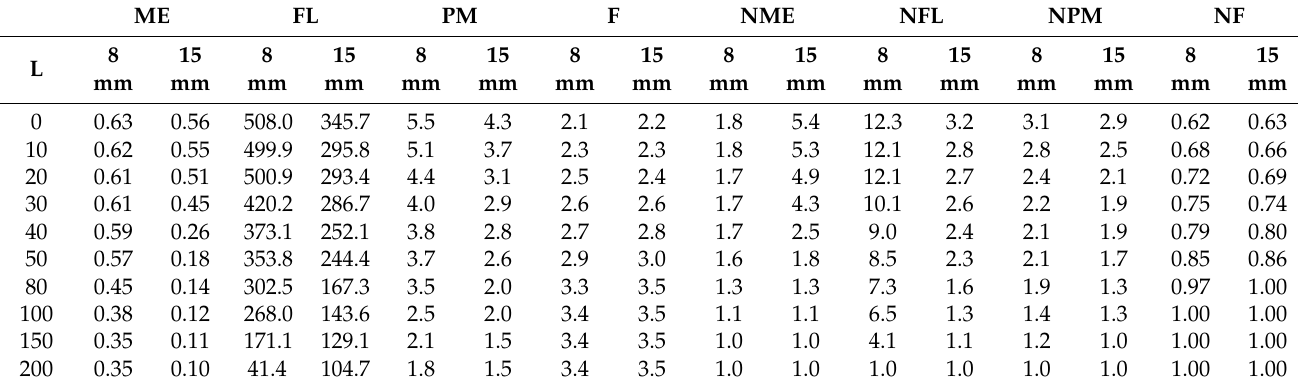
Table 1. MARSE energy, flexibility, peak magnitude and corresponding frequency of wavelet transform, and their nor- malized values.